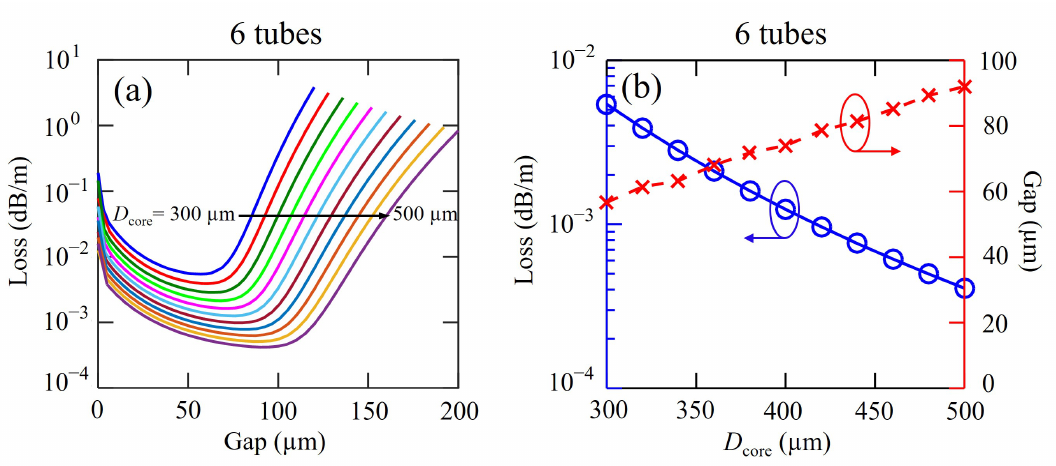
Figure 3. ( a ) Loss as a function of gap in fibers with different core diameters. ( b ) Minimum loss and the corresponding optimum gap in fibers with different core diameters. The number of cladding tubes is six.